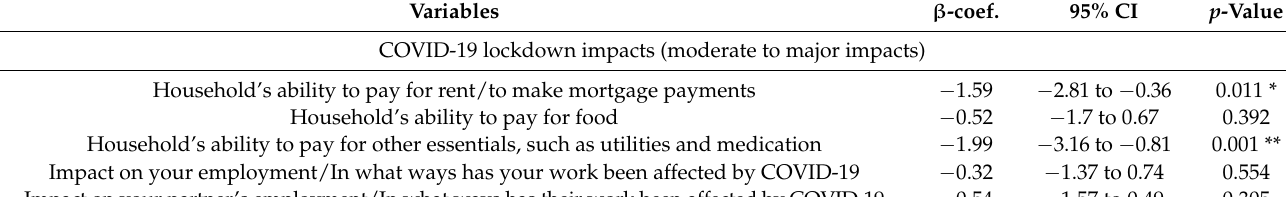
Table 4. Cont. Variables β -coef. 95% CI p